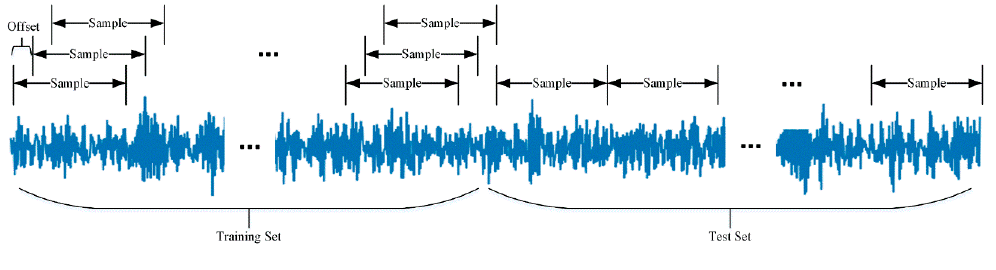
Figure 3. Data enhancement diagram.